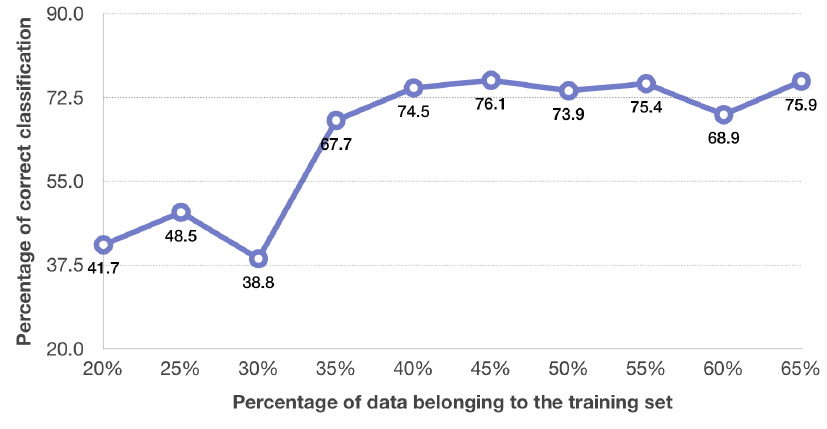
Figure 4. Efficiency plot of ST-GCN classifier. Table 1. Classification results obtained for the ST-GCN network.